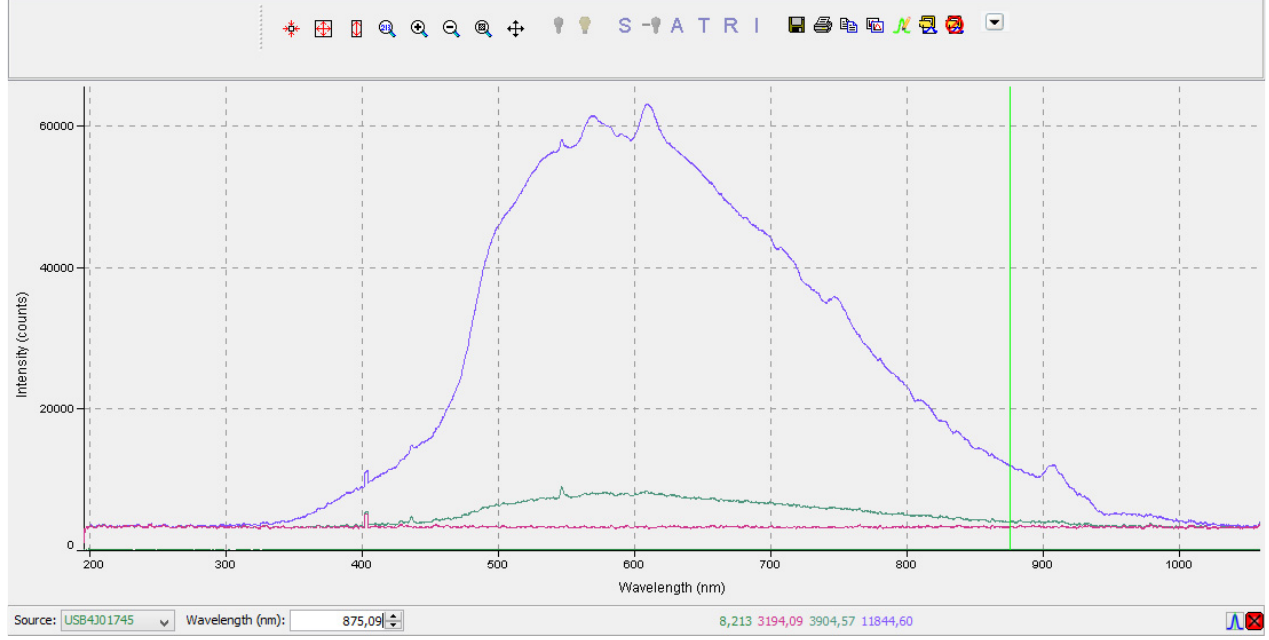
Fig. 5. The gelatin phantom spectra